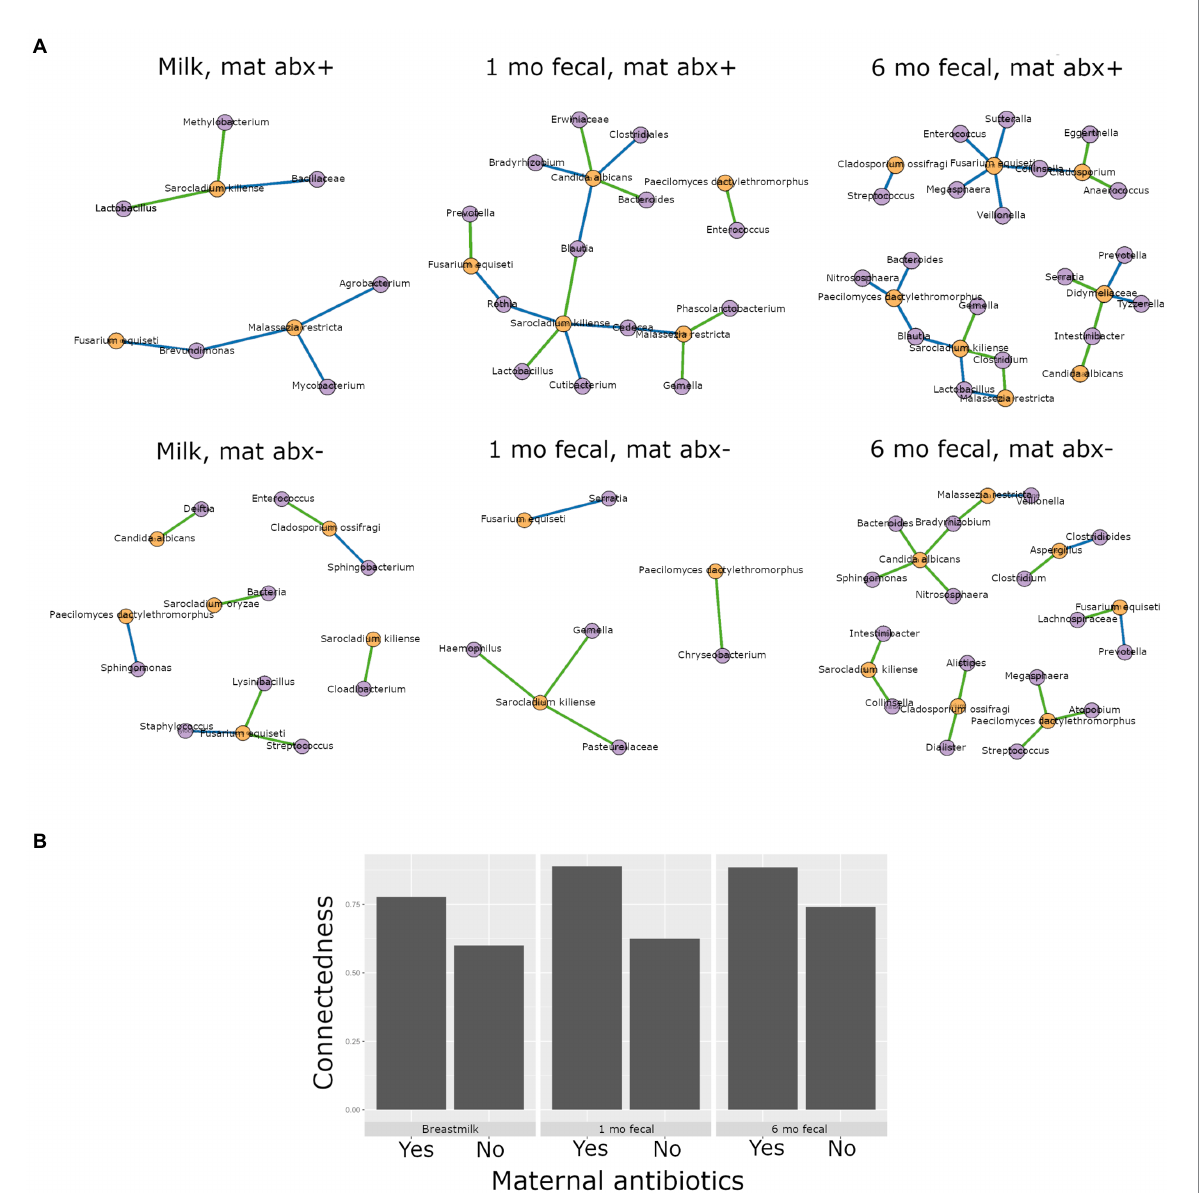
FIGURE 8 Interkingdom relationship comparisons by maternal postpartum antibiotic exposure. Panels in A are interkingdom network maps of significant interactions between bacterial (purple) and fungal (orange) taxa and are organized by sample type. Blue line, negative correlation; green line, positive correlation. Plot in B is of interkingdom connectedness values (see Methods) by sample type. Sample n’s included in network analyses for Maternal postpartum antibiotic exposed (mat abx +, top row): breastmilk 15, 1-month feces 24, 6-month feces 13 and for Maternal postpartum antibiotic unexposed (mat abx -, bottom row): breastmilk 60, 1-month feces 76, 6-month feces